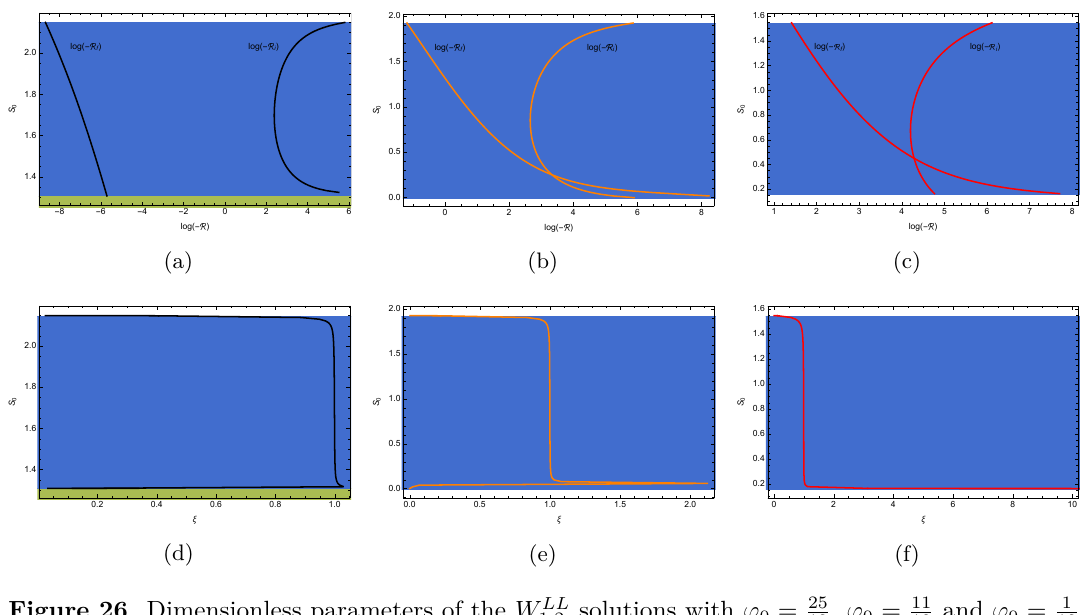
Figure 26 . Dimensionless parameters of the W LL (black, orange and red curves in figure 25a). Notice that in figures (d) and (e) at the bottom of the graphs, both curves first go to right and then return to ξ = 0